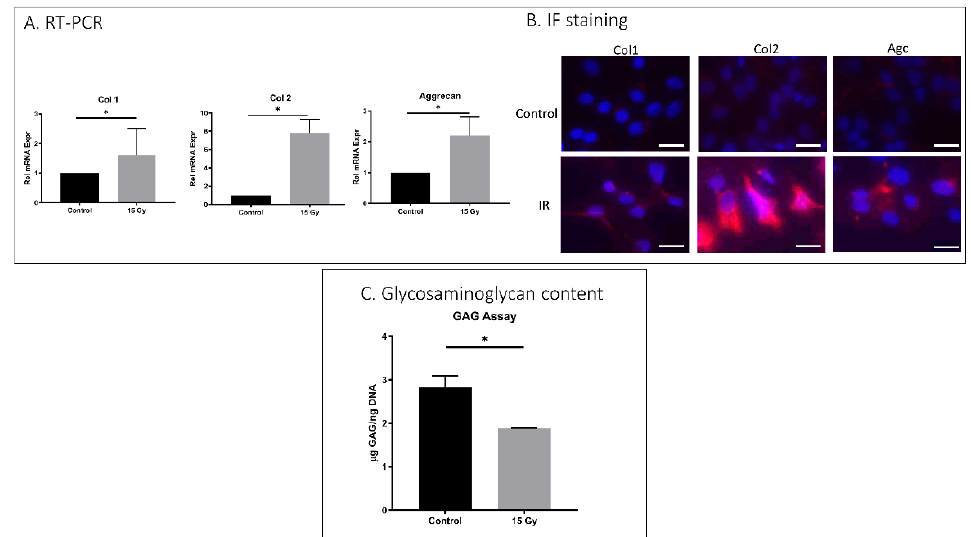
Figure 3. IR treatment effects on matrix anabolism in rat AF cells. Rat AF cell cultures were treated with 15 Gy IR and incubated for 5 days to establish senescence. ( A ) qRT-PCR revealed increased mRNA expression of collagen-1, collagen-2, and aggrecan in IR-treated AF cells compared to un- treated AF cells gene expression. ( B ) Immunofluorescence showed increased collagen-2 but un- changed collagen-1 and aggrecan protein expression with 15 Gy of ionizing radiation administration. ( C ) DMMB assay for total glycosaminoglycan (GAG) content showed a decrease in GAG in IR-treated AF cells compared to untreated control. Data shown as an average of n = 3 with one standard deviation. * p ≤ 0.05.